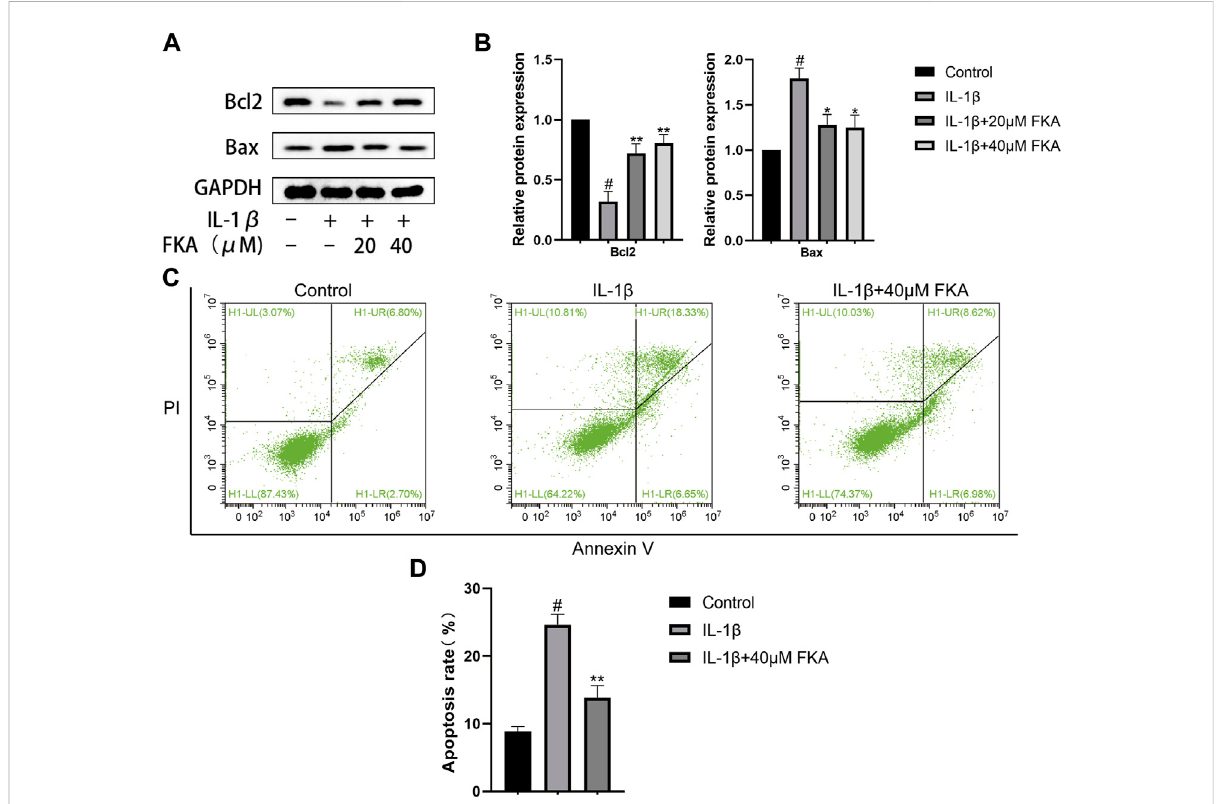
FIGURE 4 Impacts of FKA on IL-1 β -induced apoptosis in mouse chondrocytes (A) Western blot fi ndings revealing Bax and Bcl2 expression in chondrocytes. (B) Quantitative analysis of protein expression. (C) The apoptosis rate of chondrocyte cells was detected by fl ow cytometry. (D)